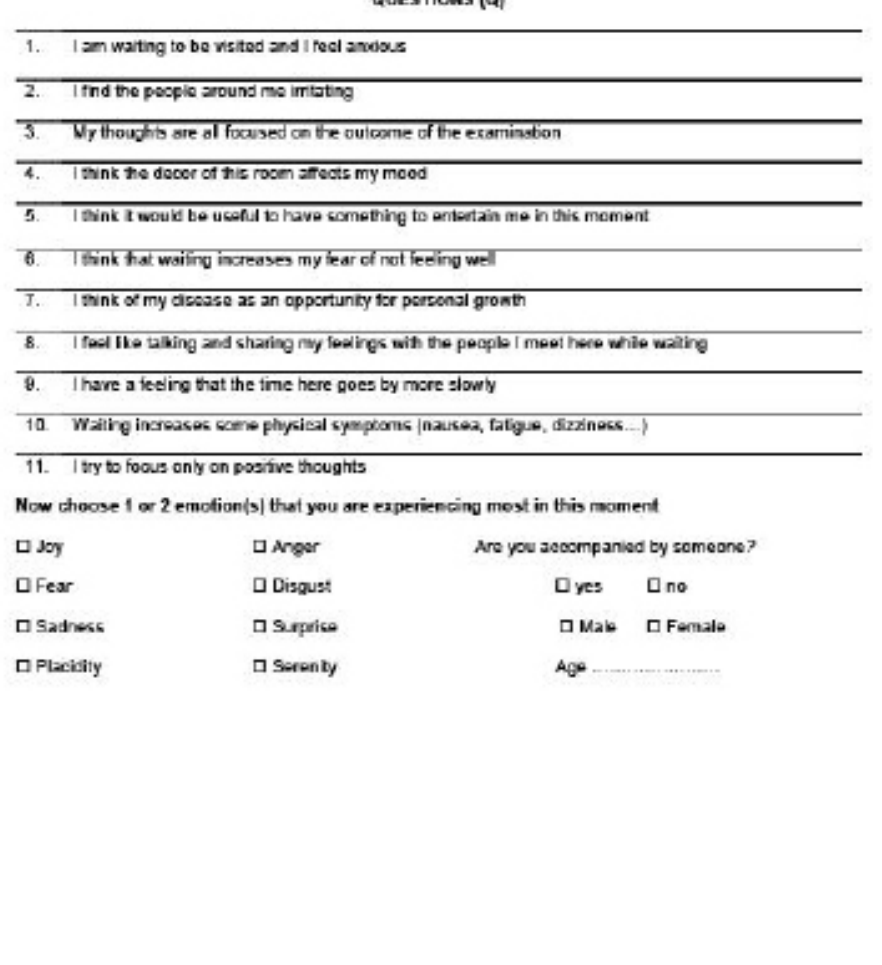
Figure 2 . Questionnaire administered in Consultation rooms and